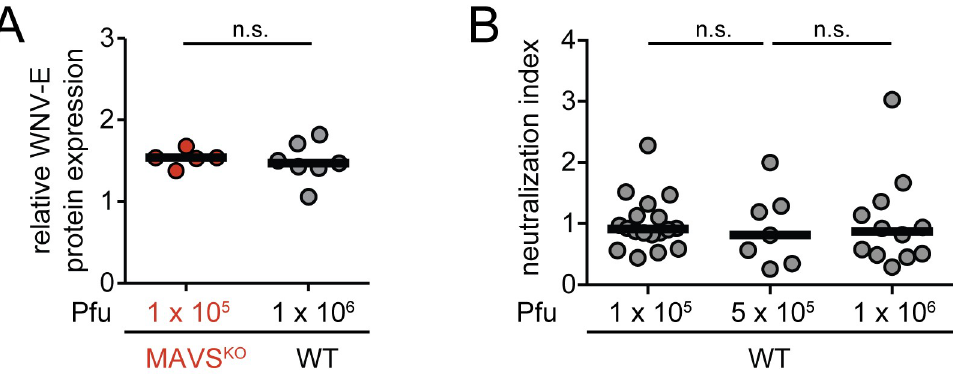
calculate the neutralization index. Shown are the combined data of 3 experiments. Each dot represents one mouse, the line represents the median. ns, not significant; Mann-Whitney